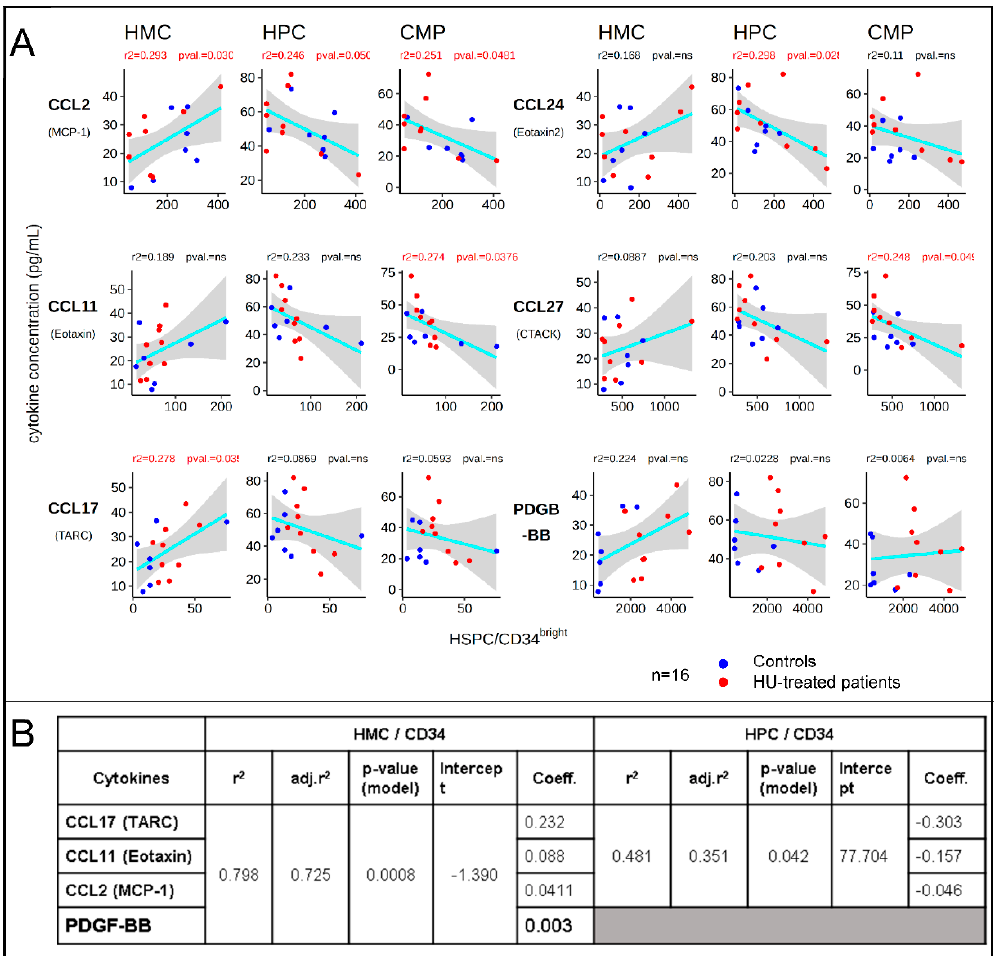
Figure 4. Correlation between plasma chemokine concentrations and HMC and HPC / CD34 bright cells. ( A ) Plots illustrating the linear correlations between the percentage of circulating HSPCs and the plasma concentration of the cytokines. Cyan line represents the linear regression; grey smooth area represents the 95% confidence intervals ( r 2 and p -values are provided above each graph). ( B ) Table illustrates the result of multiple regression analyses. A four-chemokine model explains about 80% ( r 2 = 0.798) of the variation in the percentage of HMC per CD34. A three-chemokine model explains about 50% ( r 2 = 0.481) of the variation in the percentage of HPC per CD34. In these models, CCL17 and CCL11 are the two most influential chemokines.